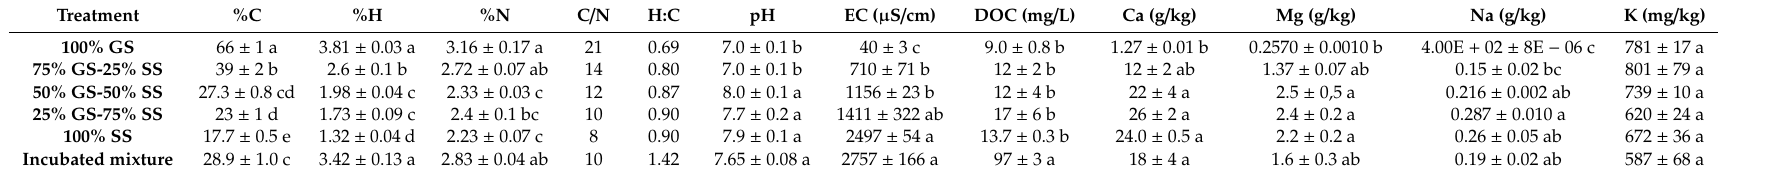
Letters are comparing the treatments in each row.